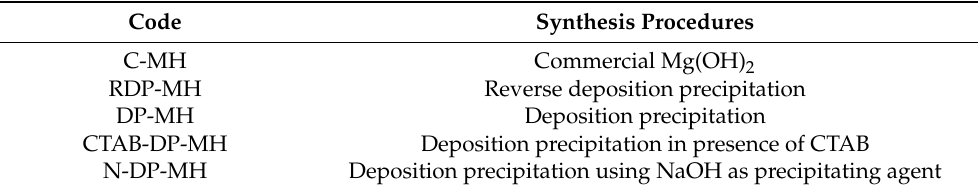
Table 1. Samples’ codes, synthesis